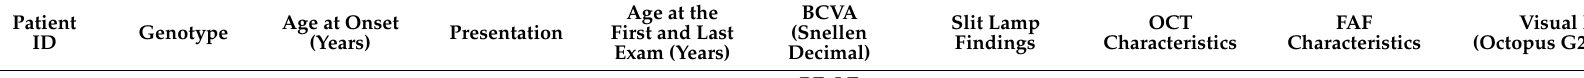
Table 1. The genetic and clinical characteristics of our patients with the novel variant in DRAM2